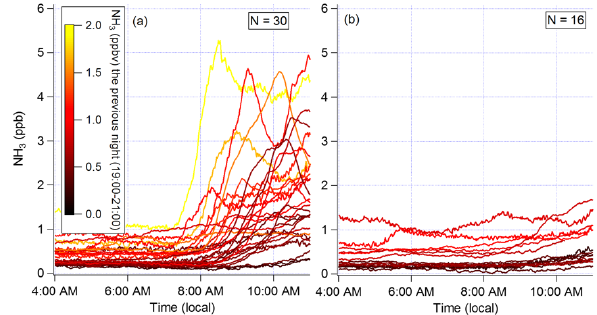
Figure 4. Time series of NH 3 mixing ratio (in ppb) from 04:00 to 11:00 on (a) mornings with dew and (b) mornings with no surface wetness. Traces are coloured according to the average NH 3 mixing ratio measured the previous night between 19:00 and